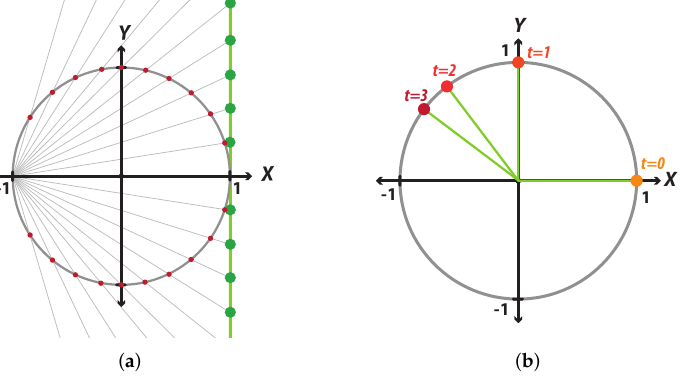
Figure A2. Rational parameterization of the unit circle. ( a ) Representation of the stereographic projection for the unit circumference. ( b ) Some points on the unit circle according to the half- turn